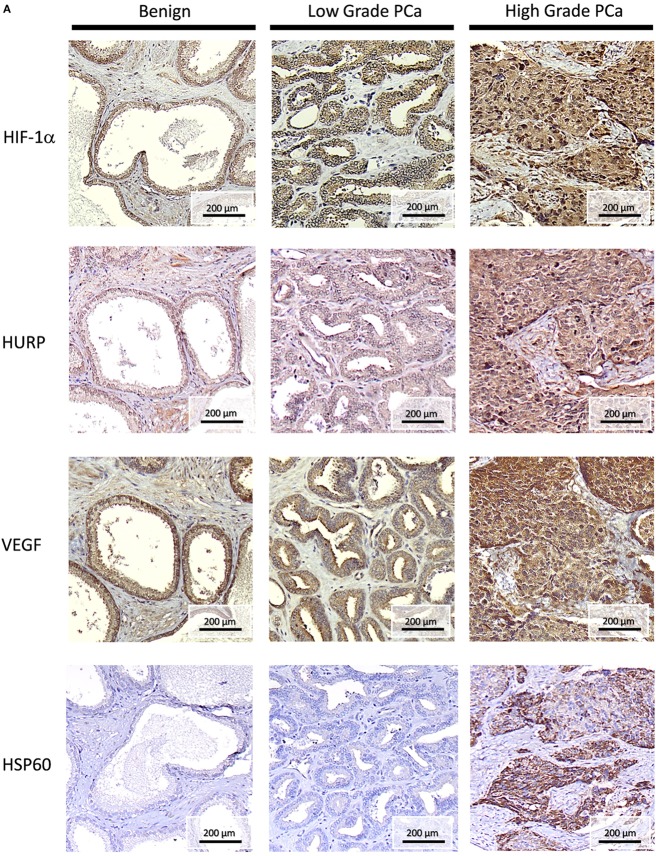
Histopathology of HURP and hypoxia-sensitive molecules in association with prostate cancer progression. Hepatoma upregulated protein (HURP), hypoxia-inducible factor 1-alpha (HIF-1α), Vascular endothelial growth factor (VEGF), and Heat-shock protein 60 (HSP60) immunostaining was assessed in benign tissues, Gleason <7 low grade PCa, and Gleason >7 high grade PCa tumors. Slides were counterstained in hematoxylin and mounted. Representative images of HURP, HIF-1α, VEGF, and HSP60 expression in bening tissue, low grade and high grade PCa tissues are shown. (A) Analysis of immunostaining intensity. Under a 100× magnification, the stain intensity was graded as no stain, weak, moderate, and strong stain. (B) Subcellular localization is shown under a 400× magnification.